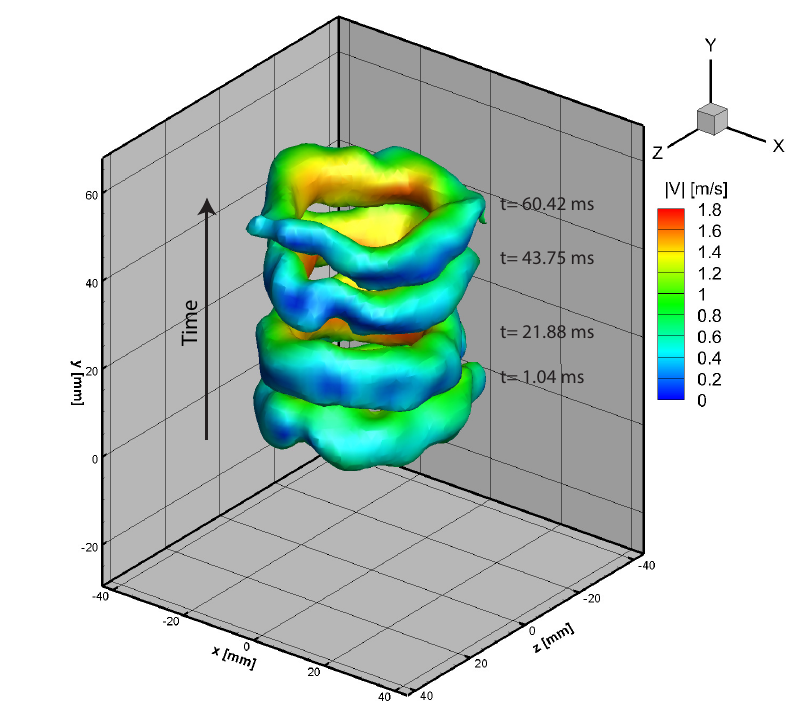
Figure 6. Time evolution of surfaces with isovorticity magnitude of | ω | = 220 s − 1 . The color of the surface represents the velocity magnitude where we can see that the inner surface near the axis of symmetry of the vortex ring, has a larger